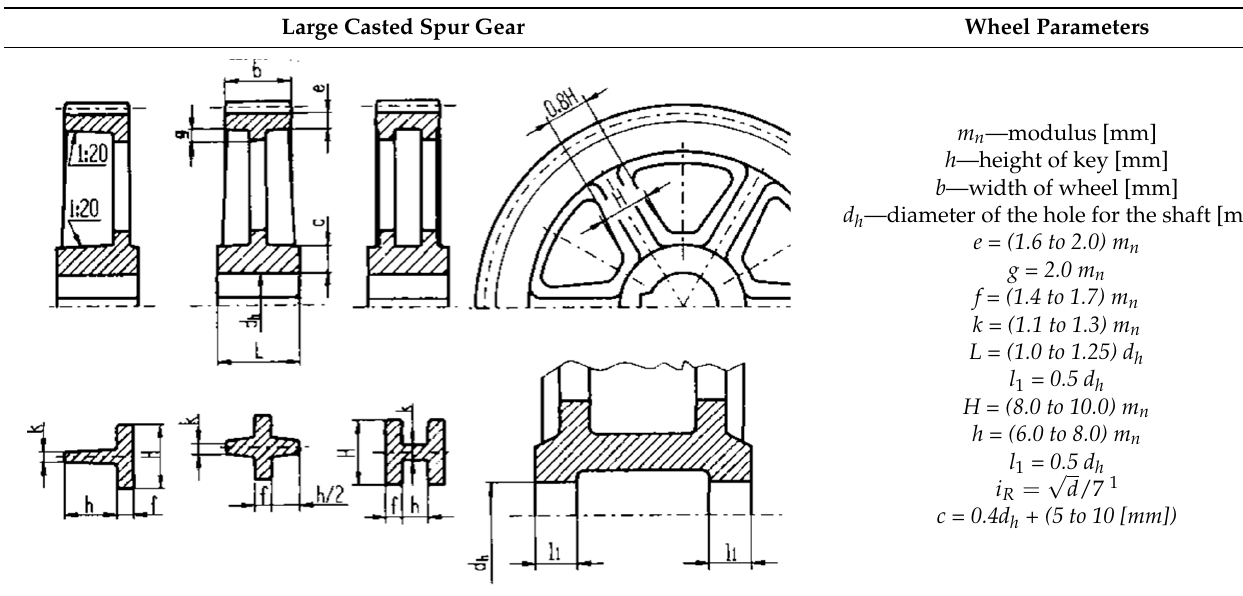
Table 4. Large casted spur gear—basic geometric parameters.